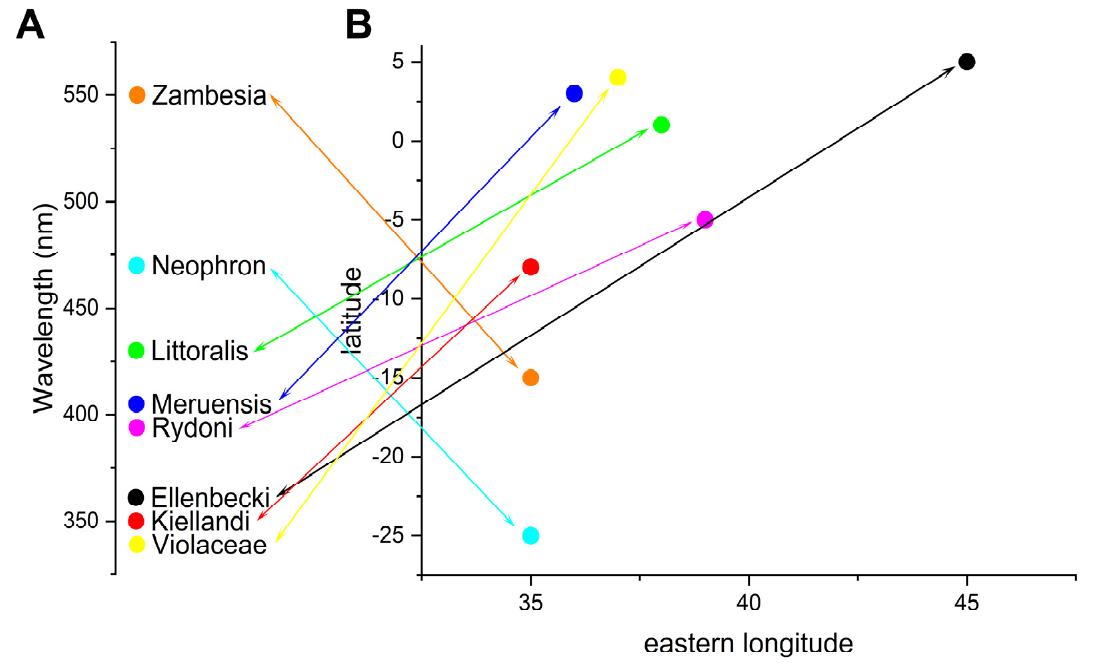
Figure 8. ( A ) Hypothetical grade of Euphaedra neophron subspecies colour tuning arranged on the basis of the peak wavelength. ( B ) The matching geographical positions of the populations. Data used for the compilation: E. n. ellenbecki = violet (360 nm), Somalia (5 N; 45 E); E. n. kiellandi = violet (350 nm), Tanzania (8 S; 35 E); E. n. littoralis = blue (430 nm), Kenya (1 N; 38 E); E. n. meruensis = blue (410 nm), Kenya (3 N; 36 E); E. n. neophron = blue (470 nm), Mozambique (25 S; 35 E); E. n. rydoni = blue (390 nm), Pemba Island (5 S; 39 E); E. n. violaceae = violet (340 nm), Kilimanjaro (4 N; 37 E); E. n. zambesia = green (550 nm), Malawi (15 S; 35 E). Coloured arrows connect the place of morphs on the peak wavelength representation and their geographical locality.